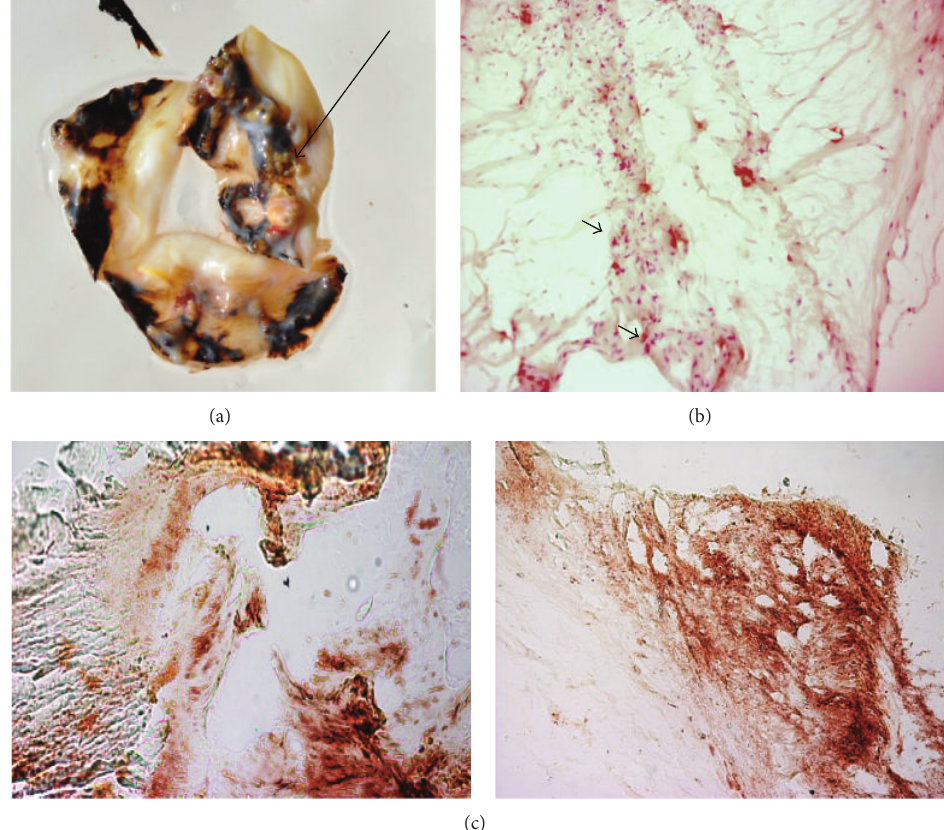
Figure 1: (a) Ochronotic pigmentation on the surface of the valve was visible. A thickening of the central areas of the cusps with nodule- like structures is visible (arrow). (b) Light microscopy (hematoxylin and eosin staining) examinations of AKU aortic valve with intense inflammatory cell infiltrate that includes large cells macroscopically corresponding to macrophages (arrows). Magnification 20x. (c) Melanin- like ochronotic pigment was particularly detected by Fontana-Masson staining. Magnification